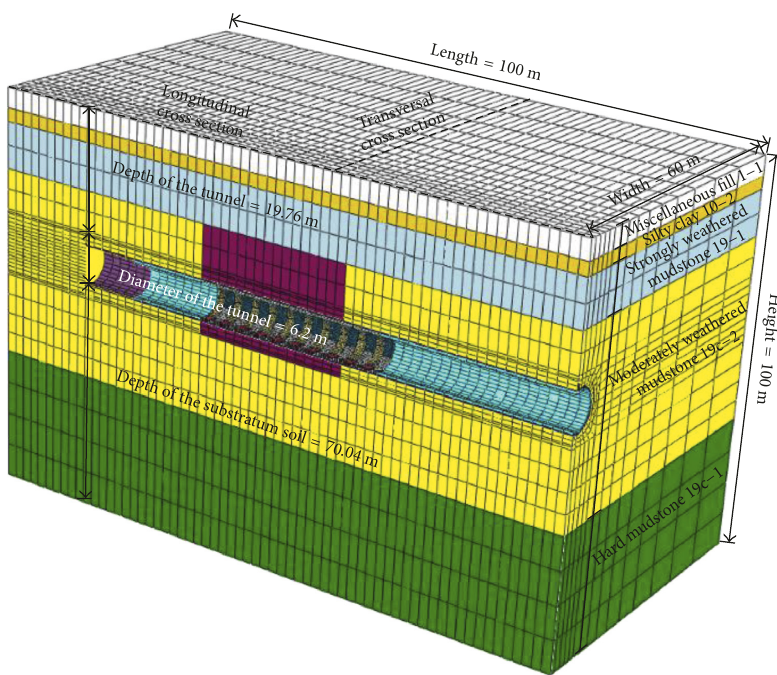
Figure 3: Integrity of the calculation